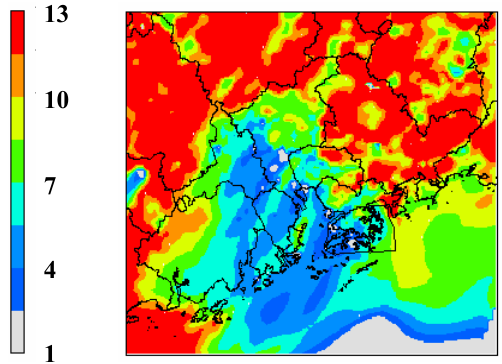
Fig. 13. Regional distribution of OPE calculated based on the over- all chemical production of O 3 and NO z over the lowest seven layers from 09:00 to 15:00LST on 16 October